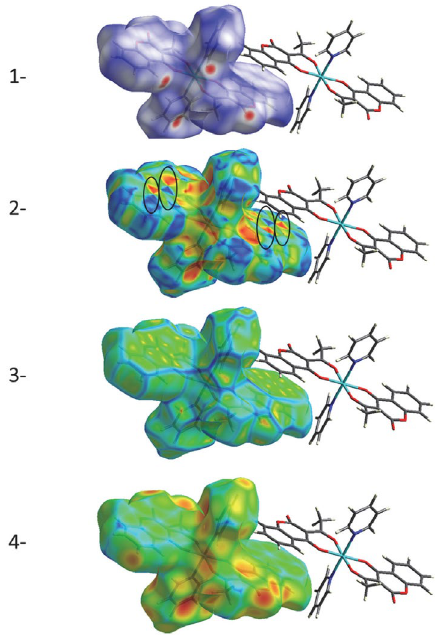
Figure 8. Hirshfeld surfaces of complex: ( 1 ) 3D d norm surface, ( 2 ) surface index, ( 3 ) curvedness, ( 4 ) d e .